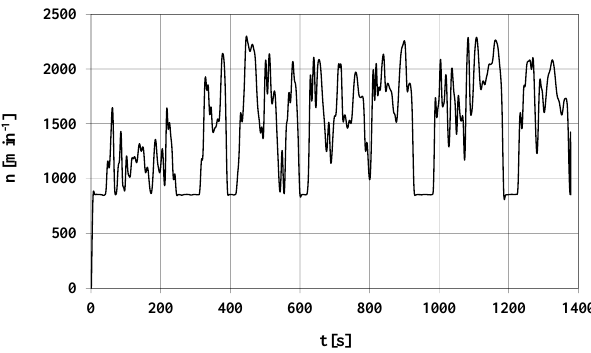
Fig. 4. The process of engine speed in the Malta test